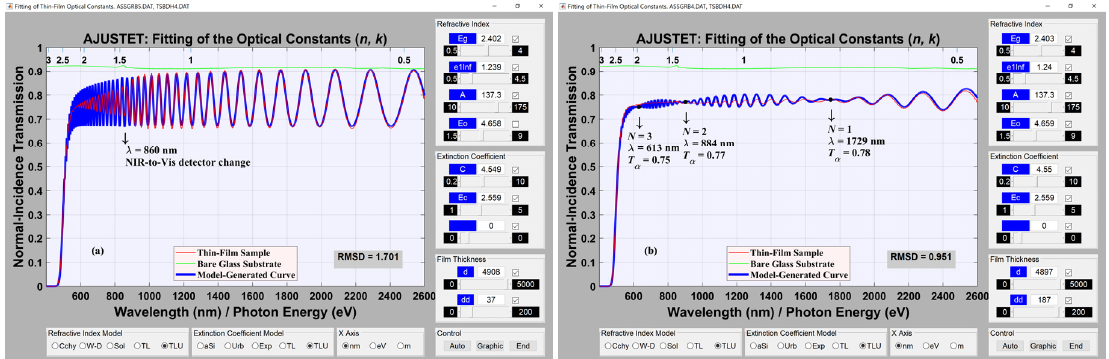
Figure 7. Spectra S3 ( a ) and S4 ( b ). Graphical-user-interface (GUI, or main window) screen for the optical characterization of thin films of amorphous semiconductor materials belonging to the MATLAB-coded computer program, AJUSTET. Comparisons between the simulated (blue line) and experimental (red line) normal-incidence transmittance spectra are displayed in this figure. Measured (green line) transmission spectrum of the glass substrate alone is compared with the former spectra.